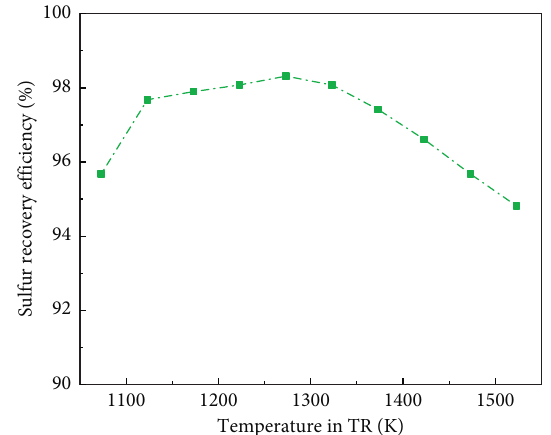
Figure 10: Sulfur recovery efficiency as a function of temperature in TR.